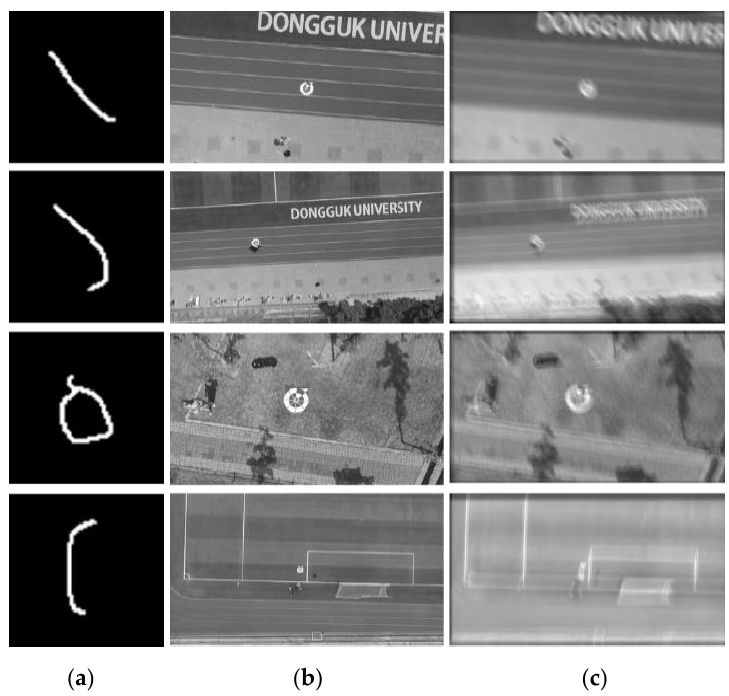
Figure 5. Examples of SMBD-DB1. ( a ) Synthetically generated kernels, ( b ) ground truth (original images), and ( c ) motion-blurred images.